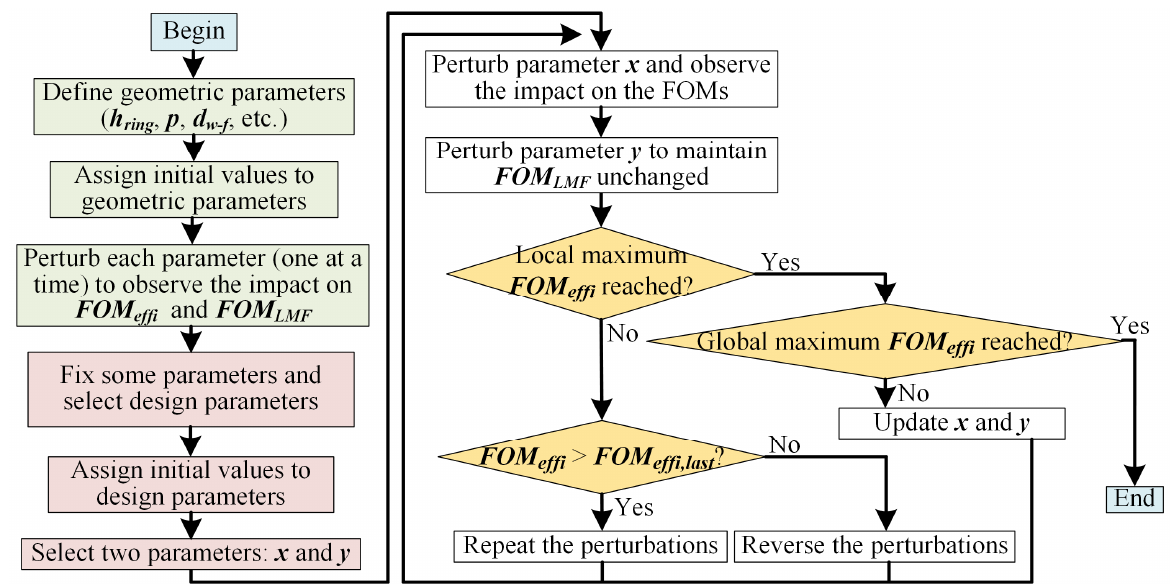
Figure 7. Flowchart of the manual optimization procedure.